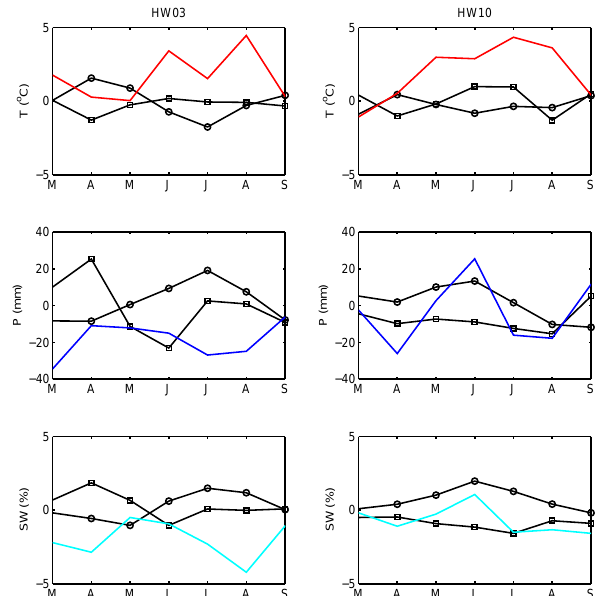
Figure 10. Normalized monthly values from March to September of (a) T anom (b) P anom and (c) SW1 anom , averaged over each region for: composites of best years (black line, circles), worst years (black line, squares), and 2003 (HW03, colour lines, left panel) or 2010 (HW10, colour lines, right panel). Units in the yy axis correspond to standard deviations of each variable. Worst years are computed excluding the heatwave year for each region. For HW03 the high (low) productivity years are 2000/2007/2011 (2001/2004/2005) and for HW10 the high (low) productivity years are 2001/2004/2005